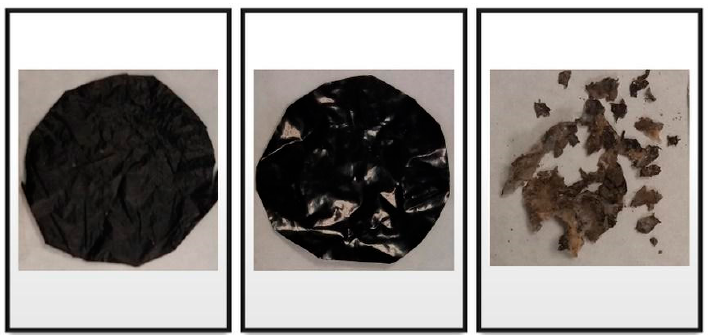
Figure 2. Representative films after ten days of mulching (left to right): Mater-Bi, polyethylene, the innovative protein-based film.